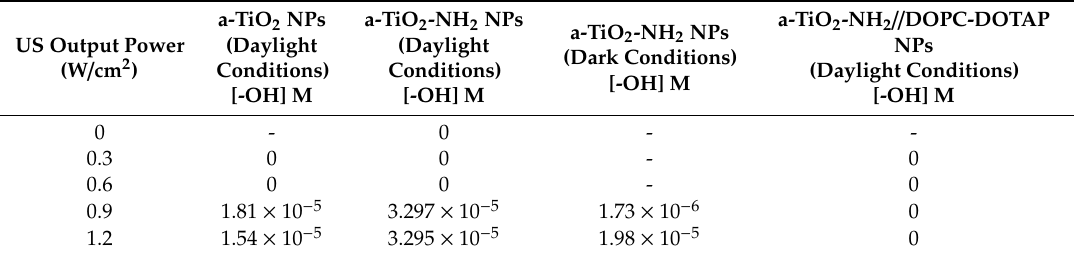
Table 2. Concentrations of DMPO-OH spin adduct obtained by using Bruker SpinFit software. All the experiments were performed in daylight. In the case of the highest ROS production, i.e., concerning the sample a-TiO 2 -NH 2 NPs, tests in dark conditions were also performed.